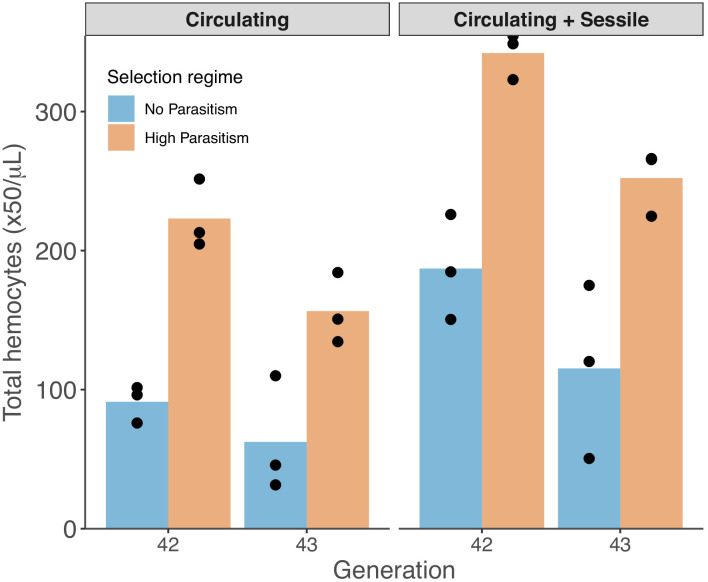
ç Concentration of hemocytes from dissected larvae without manipulation (Circulating) and after vortexing to displace sessile hemocytes into circulation (Circulating + Sessile).Points represent the mean of four biological replicas for each triplicate line from populations evolved with no parasitism (blue) and high parasitism (orange) selection regimes. Bar heights represent the mean of triplicate lines.Figure 5—figure supplement 5—source data 1.Hemocyte concentrations (circulating and circulating + sessile).